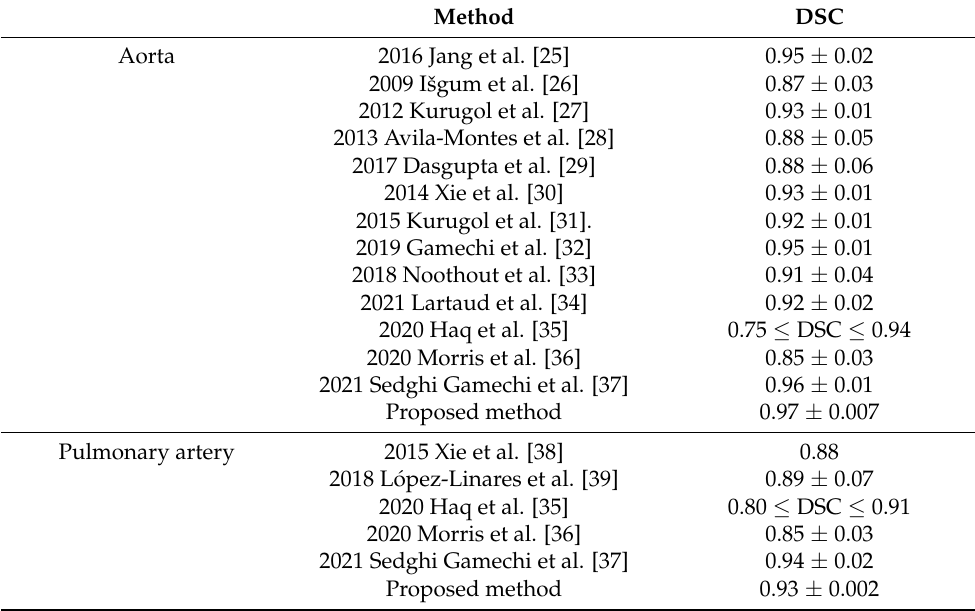
Table 3. Comparison of segmentation performance between the method in this research method and those in previous